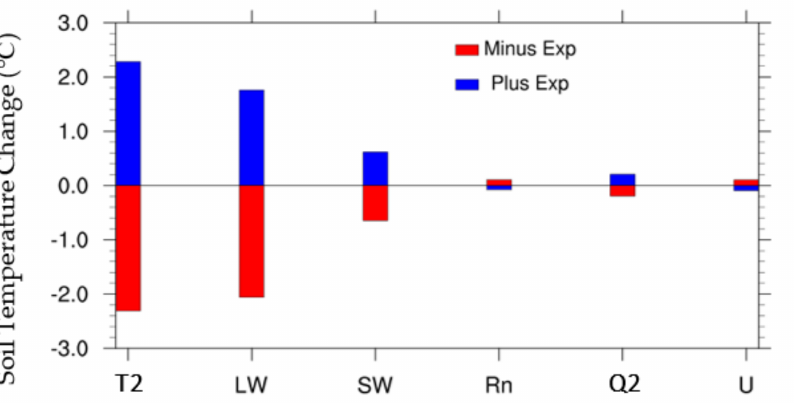
Figure 7. Annual soil temperature change (ºC) averaged over the Indian landmass from each sensitive